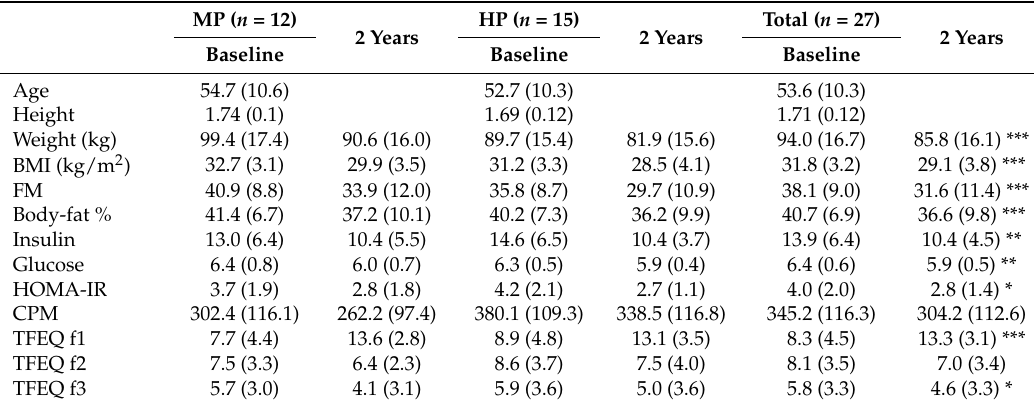
Table 1. Participant